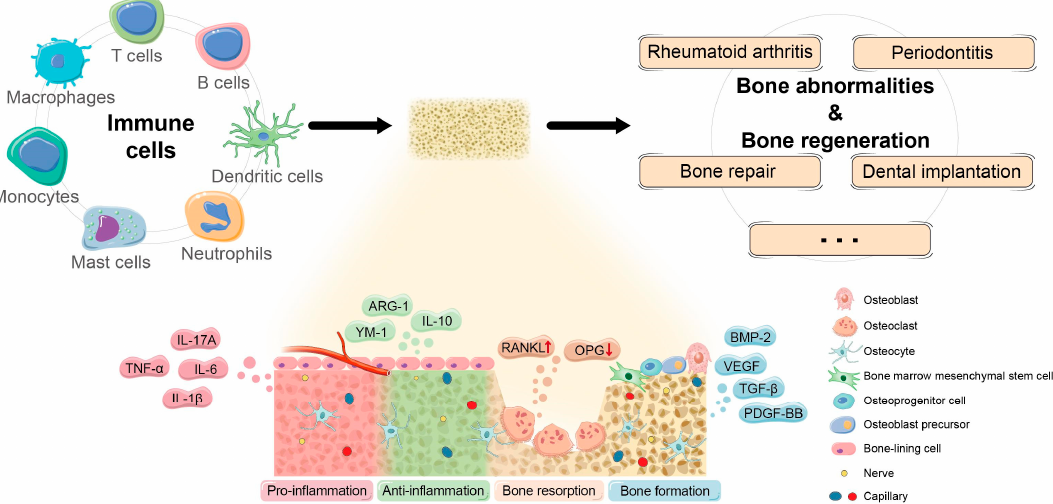
Figure 2. The mechanisms of osteoimmunomodulation in bone regeneration. Reprinted/adapted with permission from Ref. [35]. Copyright 2021 Zhou, Wu, Yu, Tang, Liu, Jia, Yang and Xiang.